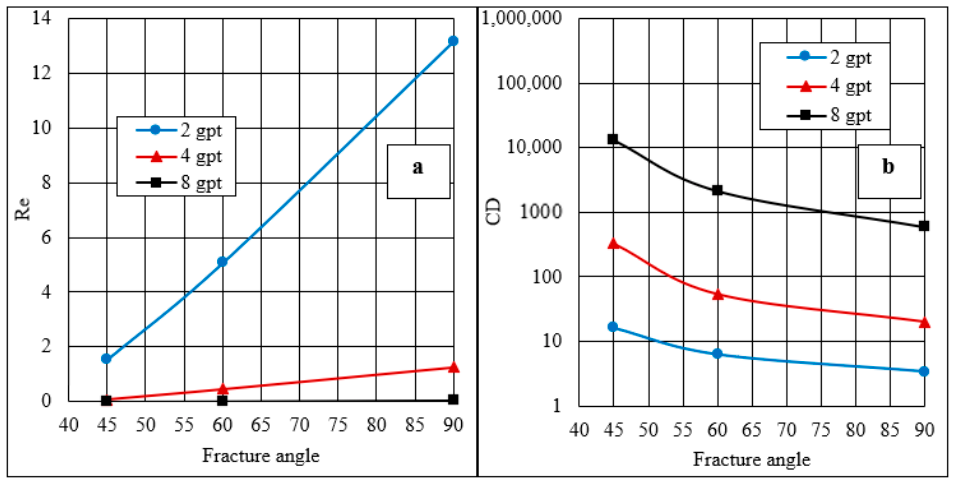
Figure 19. Fracture angulation effect on ( a ) Re and ( b ) CD using a 6 mm particle size and different HVFR concentrations.